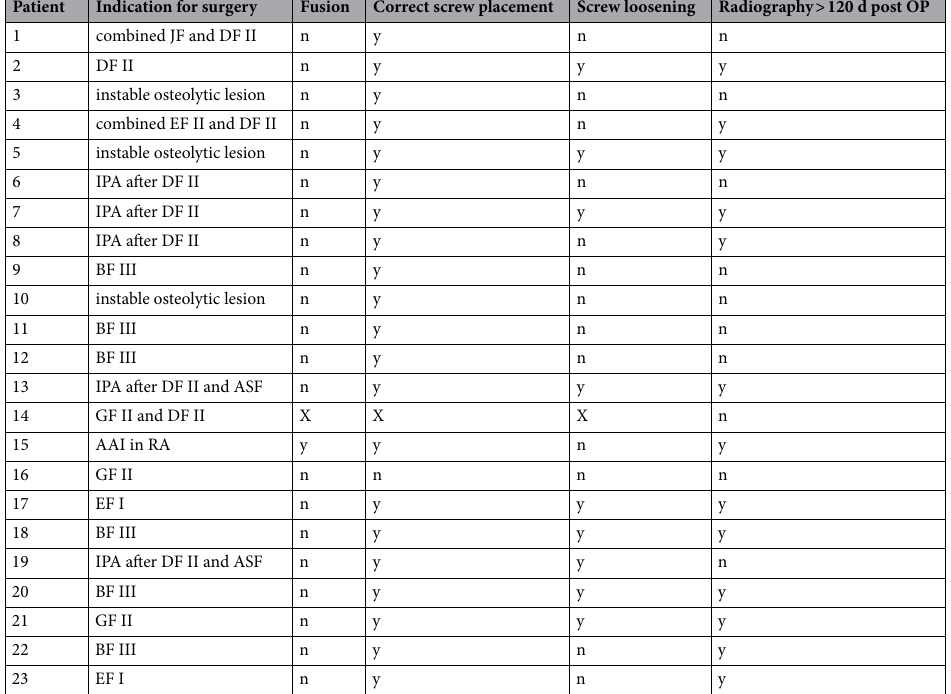
Table 2. Radiological data and indication for surgery. JF Jefferson fracture, DF Dens axis fracture (Anderson and D’Alonzo), BF Benzel fracture, EF Effendi fracture, IPA instable pseudarthrosis, ASF anterior